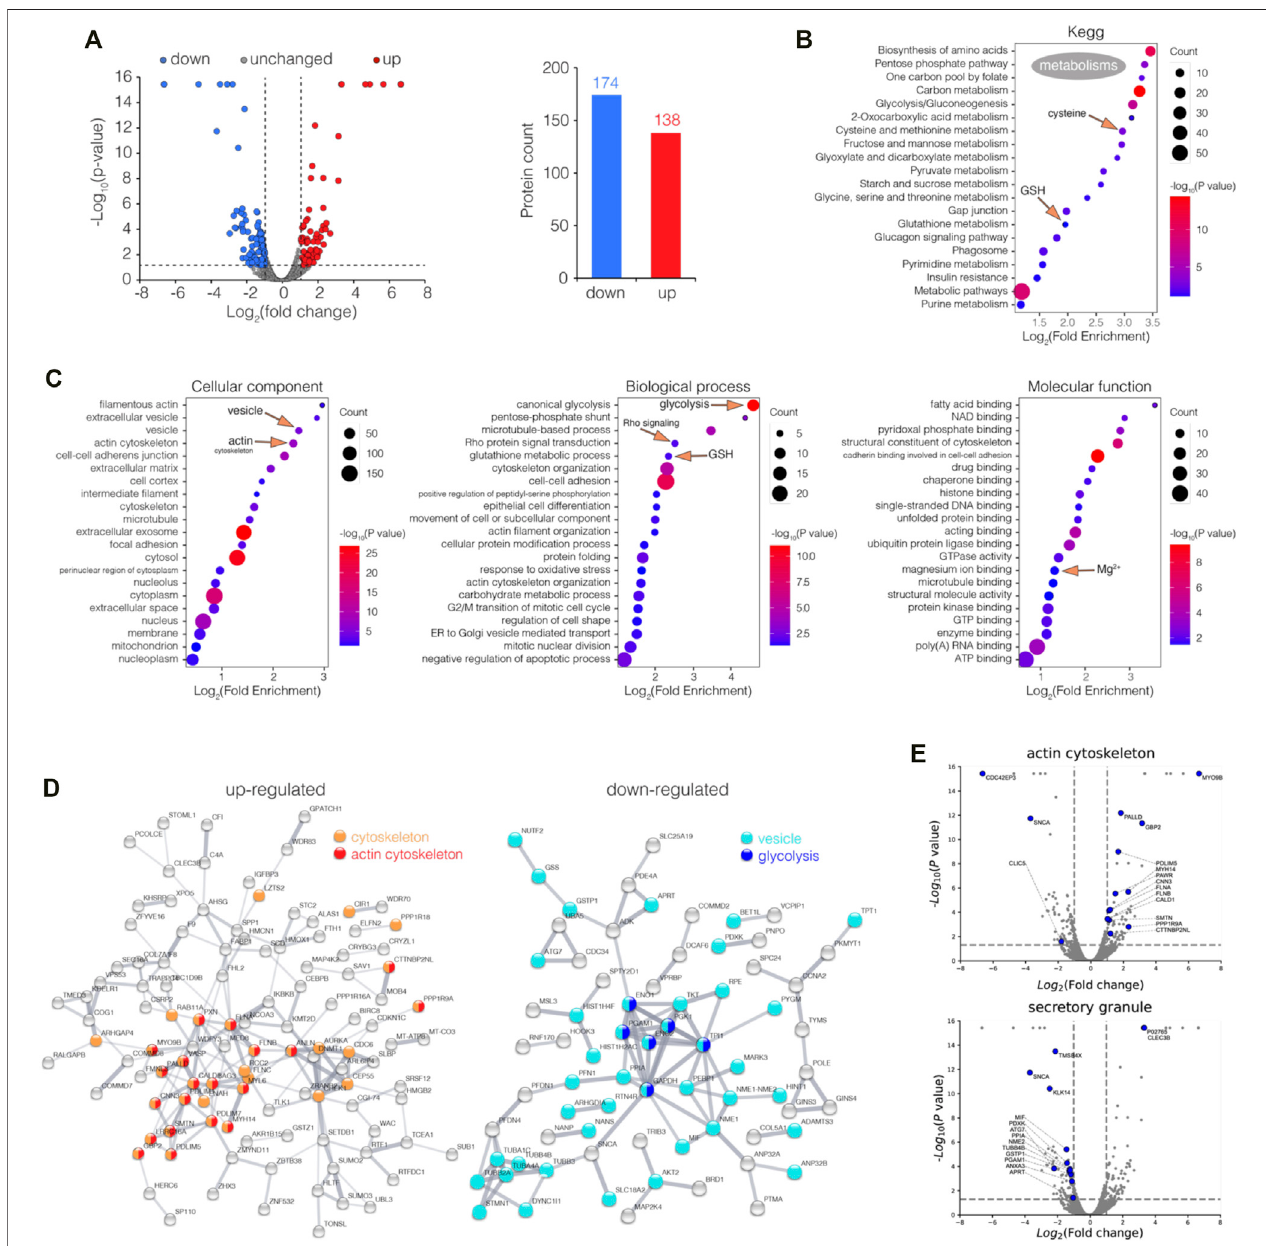
FIGURE 1 | Enrichment analysis of differentially expressed proteins (DEPs) in CBS-treated HK-2 cells. (A) Volcano plot visualization of DEPs (fold of change > 2 or < 0.5, p value < 0.05) in HK-2 cells treated with 500 μ M CBS for 48 h, and 138 and 174 proteins were up and downregulated among 6,230 proteins, respectively. (B) Enrichment analysis of DEPs in CBS-treated HK-2 cells, in perspective of KEGG, and (C) GO cellular component, molecular function, and biological process. (D) Protein – protein interaction networks ofboth upand downregulatedDEPsgenerated using STRING. (E) Volcano plotsvisualizingDEPsinvolvedin GOterms: actin cytoskeleton and secretory granule. CBS-induced proteomic alterations in GSH-depleted HK-2 cells.